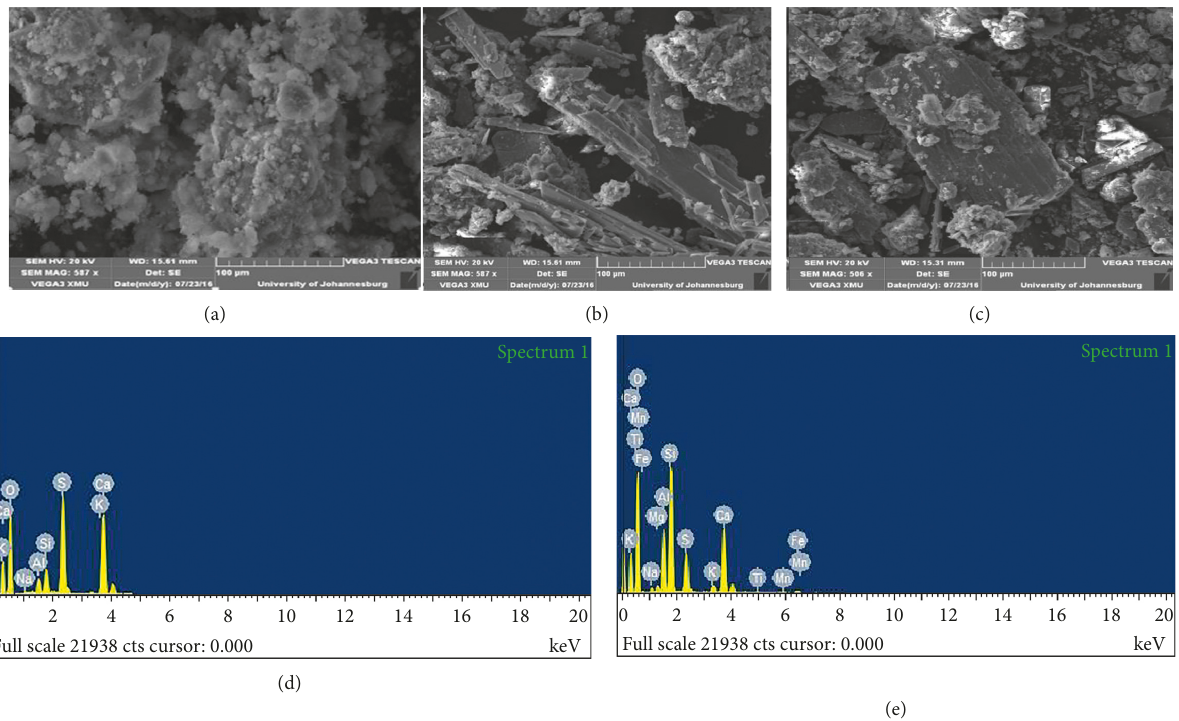
Figure 5: SEM micrograph and EDS of (a) expansive soil, (b) stabilized soil by raw PG, and (c) stabilized soil by treated PG. EDS of (d) stabilized soil by raw PG and (e) stabilized soil by treated